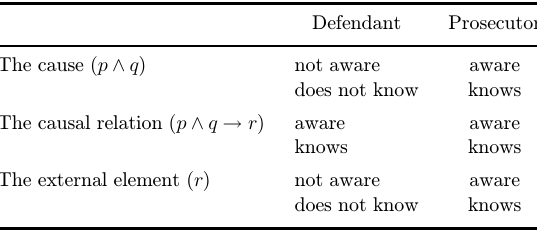
Table 1. Comparison of epistemic statuses between defendant and